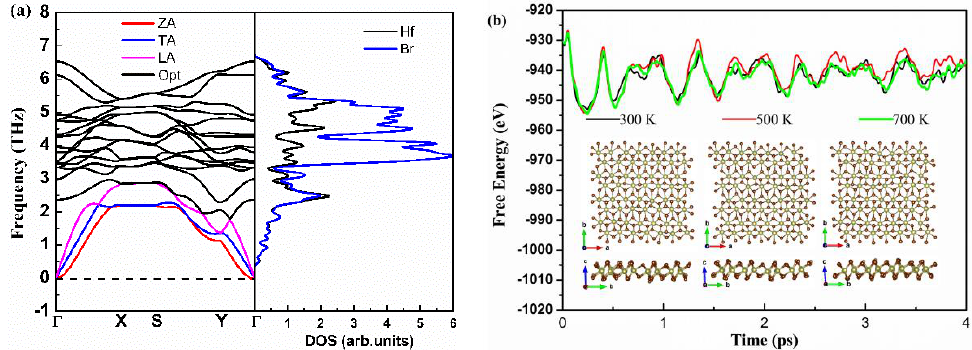
Figure 2. Calculated phonon dispersion and projected density of states ( a ), energy fluctuation with respect to time in AIMD and equilibrium structures at 300, 500 and 700 K ( b ).